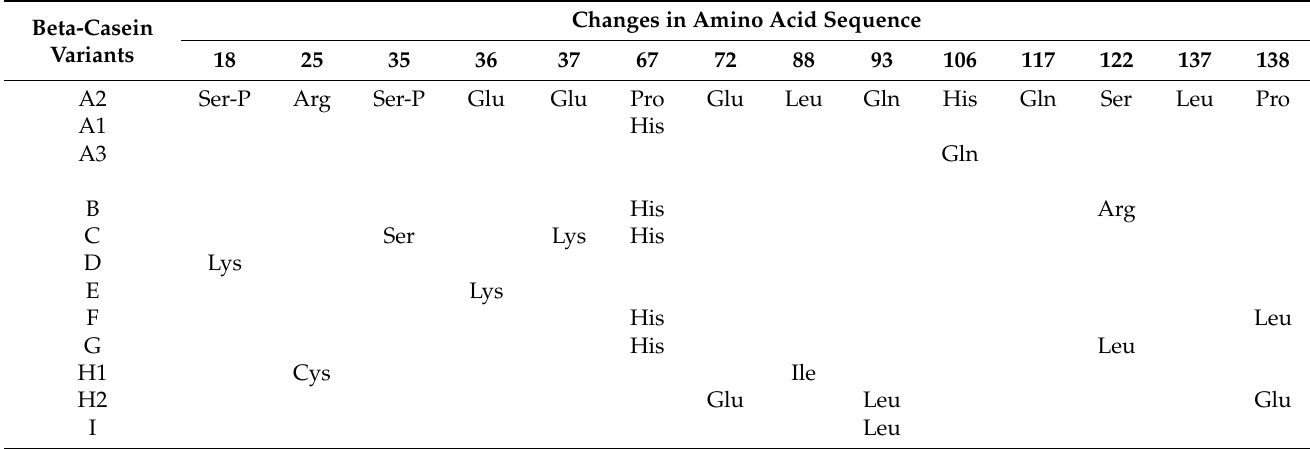
Table 2. Changes in the amino acid sequence of beta-casein